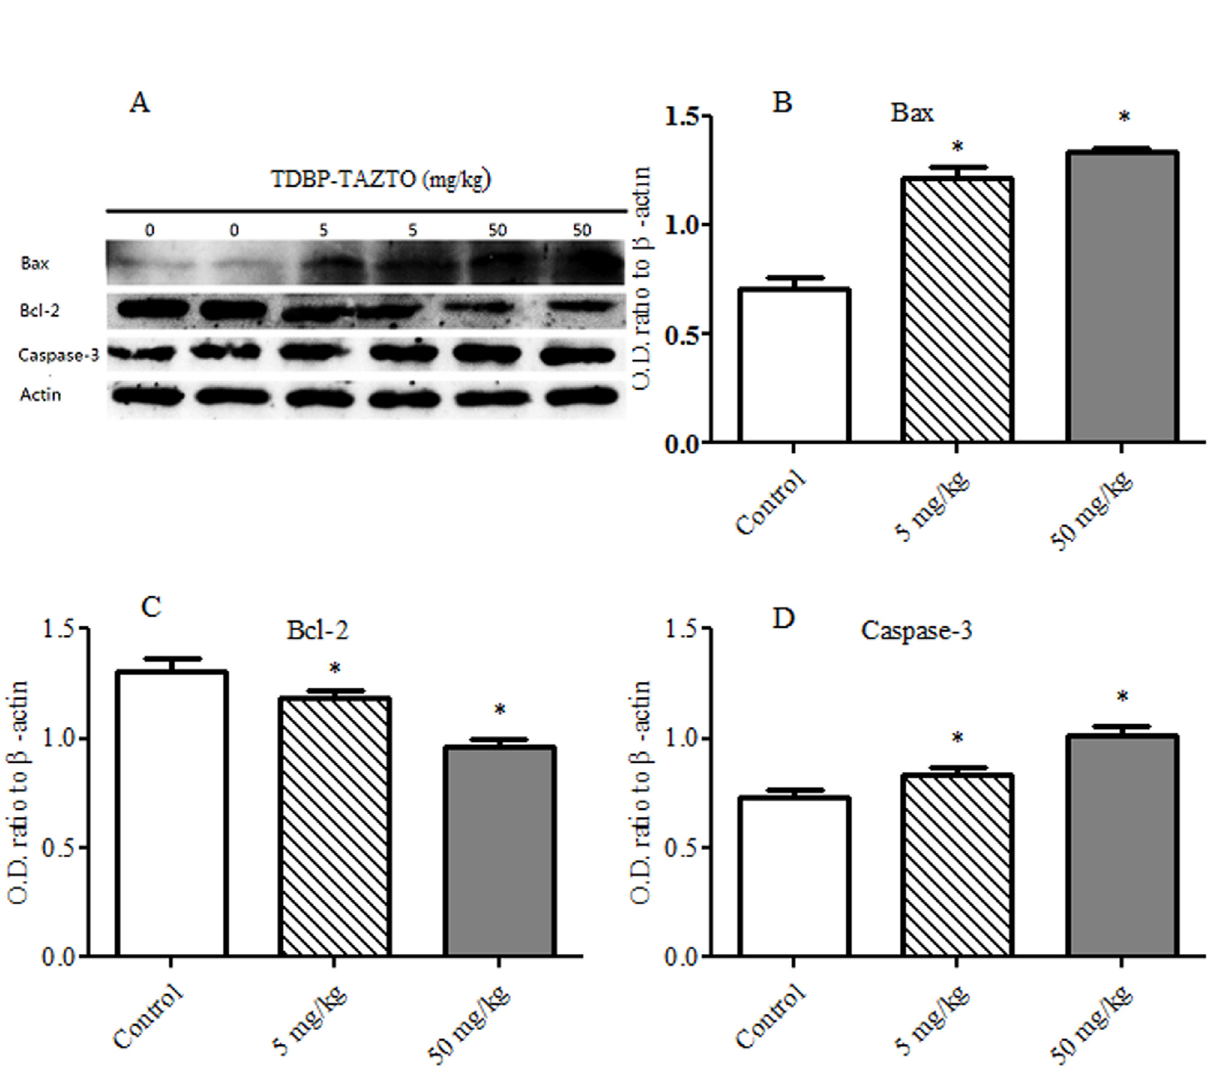
Fig 6. The effects of TDBP-TAZTO (5 and 50 mg/kg) on apoptosis-related proteins in the hippocampus. The results are presented as mean ± SE (n = 5/group). * p < 0.05, vs. control group. The O.D. values were displayed in Bax (B), Bcl-2 (C) and cleaved caspase-3 (D) normalized to β -actin.